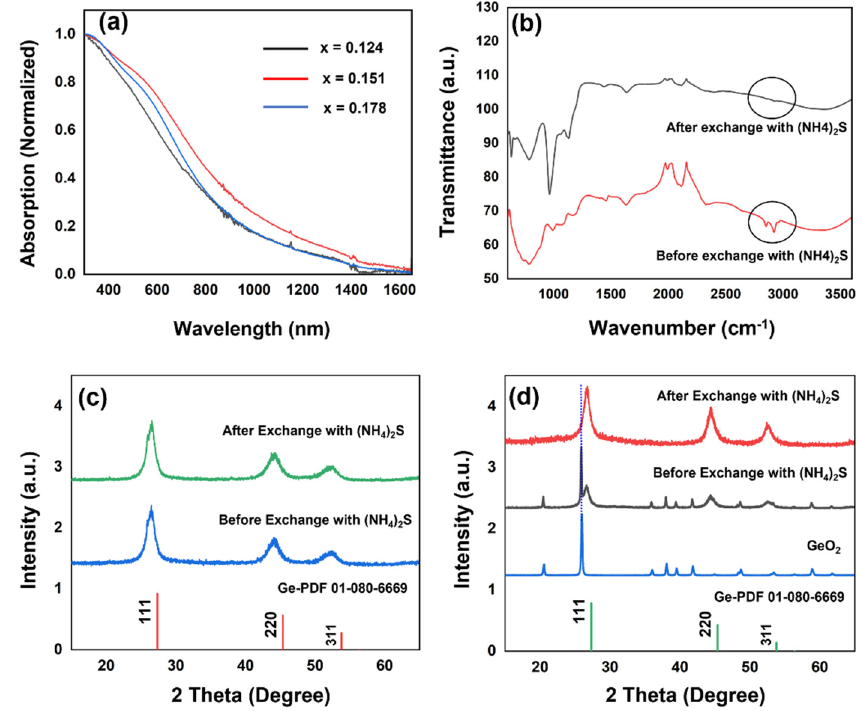
Figure 3. ( a ) UV–Vis spectrum of the prepared Ge 1 − x Sn x nanoparticles. ( b ) FT-IR spectra of Ge 1 − x Sn x nanoparticles sample before and after ligand exchange. ( c ) and ( d ) Powder XRD patterns of Ge 1 − x Sn x nanoparticles sample before and after ligand exchange.